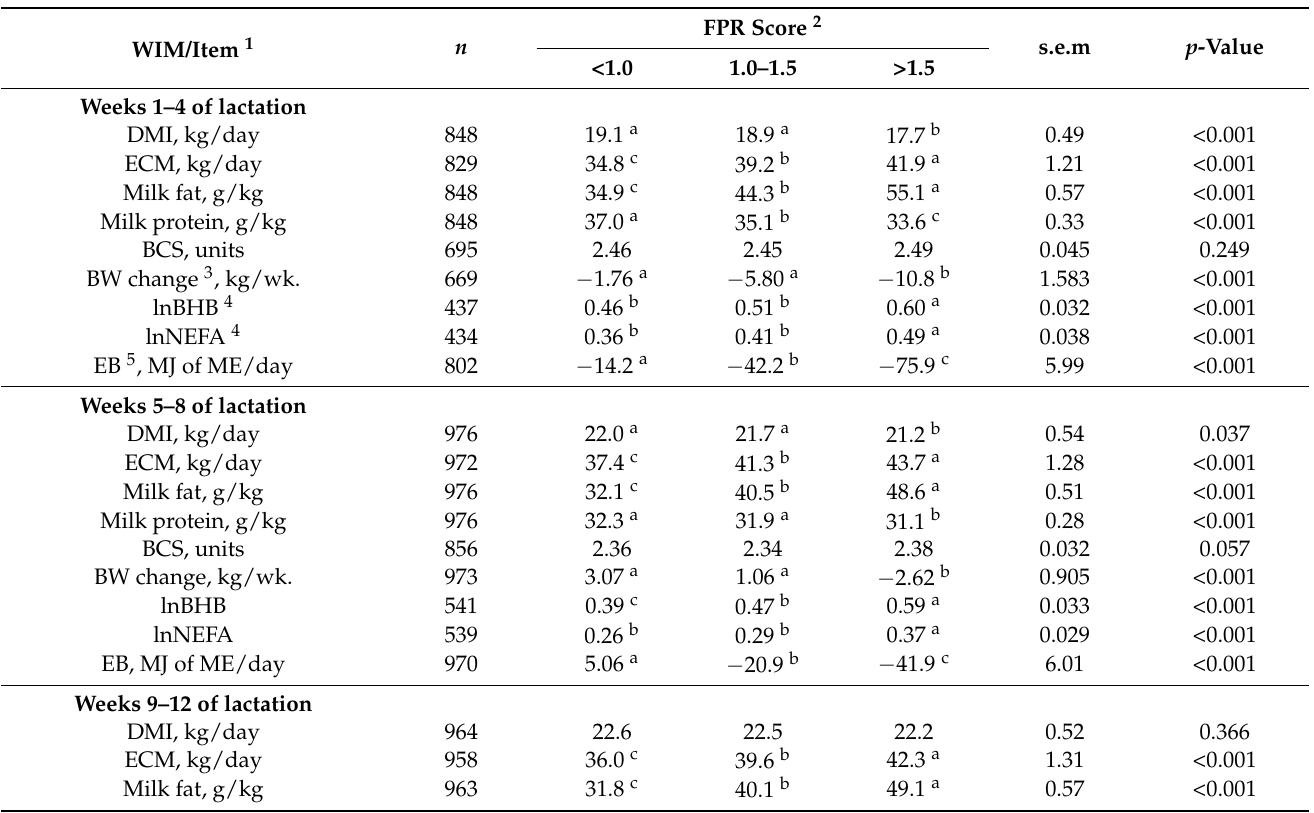
Table 7. Performance indicators and blood metabolites (adjusted least squares means: 4 wk intervals) of ≥ fourth lactation Holstein-Friesian dairy cows within three fat-to-protein ratio scores in milk during early lactation (1–20 WIM). WIM/Item 1